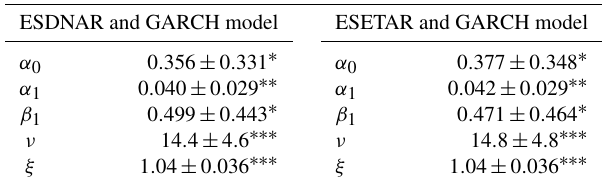
Table 4. GARCH parameter estimates for the noise in the ex- tended models. Note: “ESDNAR and GARCH” denotes the ES- DNAR model with GARCH noise, and “ESETAR and GARCH” denotes the ESETAR model with GARCH